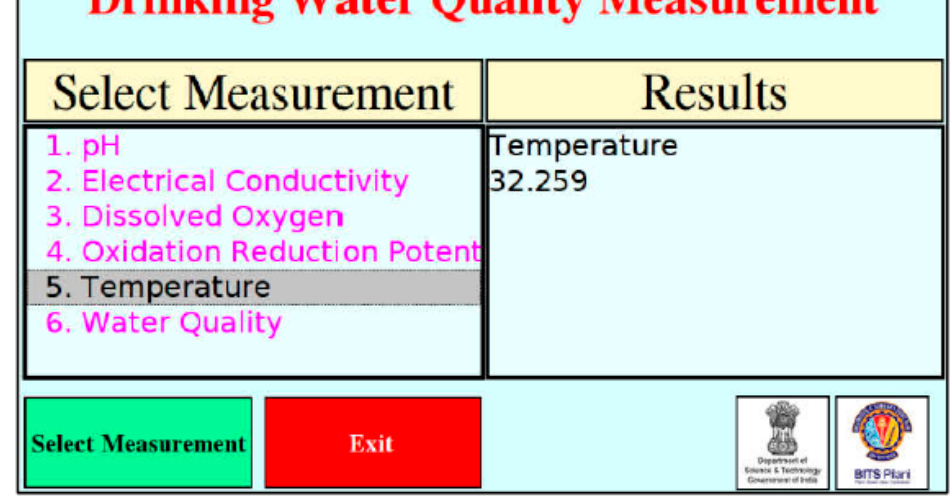
Figure 9. Graphical user interface (GUI) developed for water quality monitoring system Figure 9 . Graphical user interface (GUI) developed for water quality monitoring system [17].